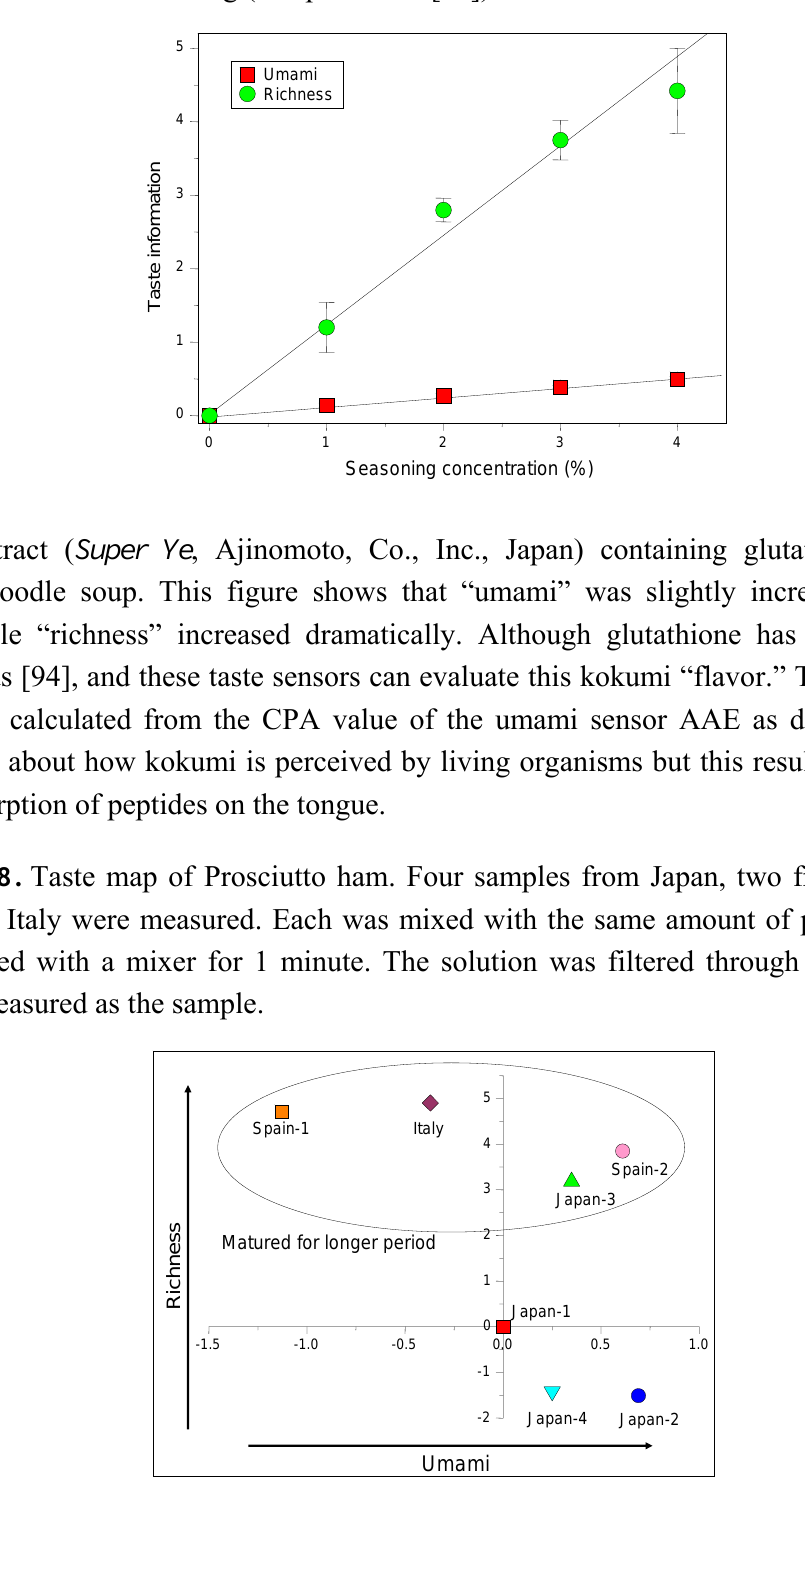
Figure 17. Effect of kokumi flavor on taste of commercial noodle soup base diluted threefold with pure water for measurement. A yeast extract ( Super Ye , Ajinomoto, Co., Inc., Japan) was used as seasoning (Adapted from [95]).